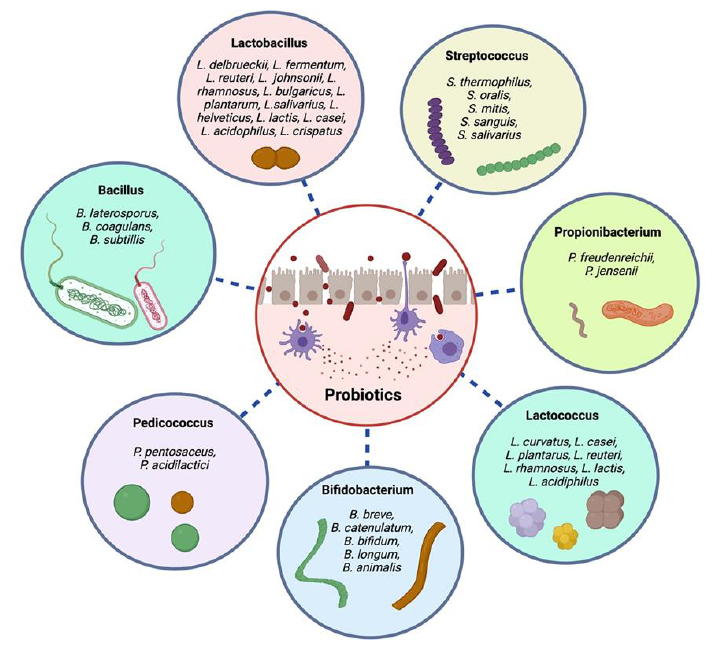
Figure 1. The most often utilized probiotic